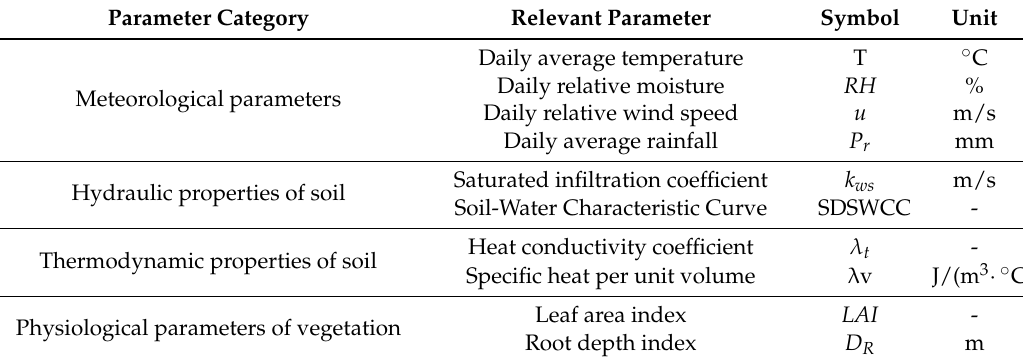
Table 2. Parameters required for the numerical